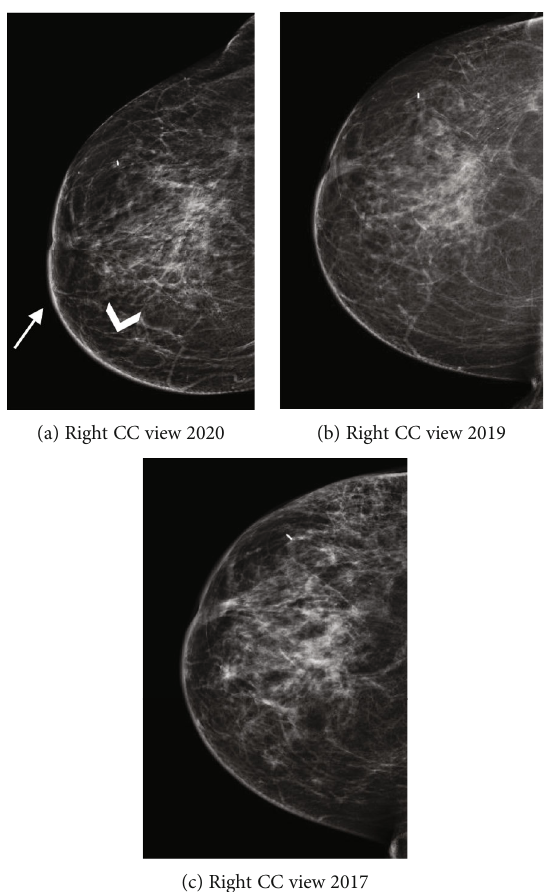
Figure 2: (a – c) Right LE image in a craniocaudal view (a) compared to the previous craniocaudal view from 2D mammography exams from one year ((b), 2019), and 3 years ((c), 2017) before show new mild skin thickening (arrow, (a)) and trabecular thickening (arrowhead,